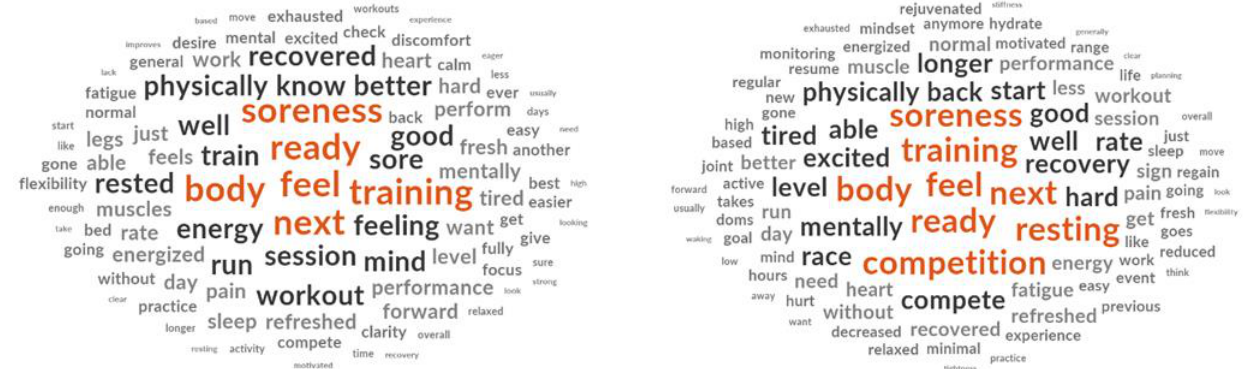
Figure 6. How endurance athletes know they have recovered from practice ( left ) and competition ( right ). This word cloud is based on the frequency of responses to the open questions. The more times a word is used the larger it appears and changes color.